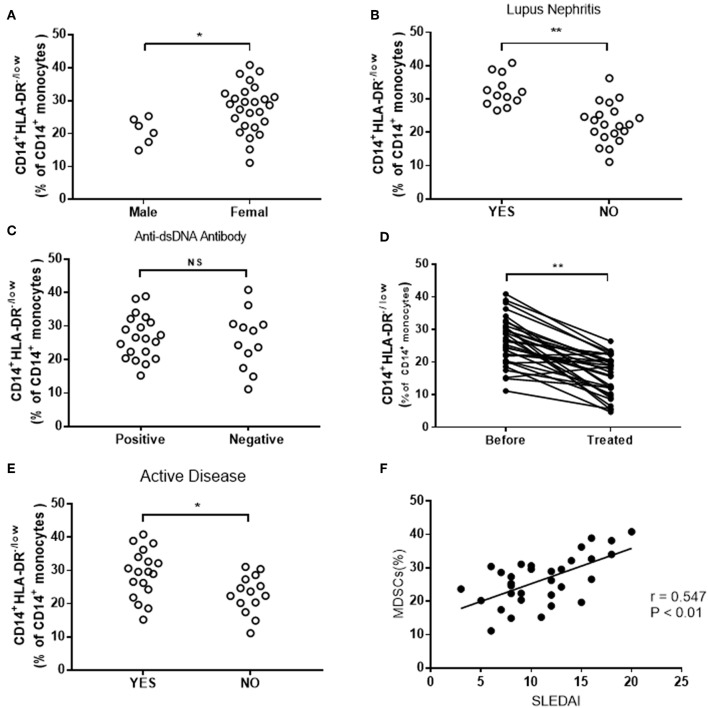
Clinical correlation of M-MDSCs in SLE patients. (A) The frequency of M-MDSCs in female patients was significantly higher than that in male patients. (B) The frequency of M-MDSCs increased in patients with lupus nephritis. (C) No significant difference was detected in M-MDSCs between anti-dsDNA-positive and anti-dsDNA-negative groups (YES, lupus nephritis; NO, non-lupus nephritis). (D) The frequency of M-MDSCs was significantly decreased after treatment. (E) The level of M-MDSCs in patients with active SLE was higher than that in patients with inactive SLE (YES, active SLE patients; NO, inactive SLE patients). (F) M-MDSCs was positively correlated with the score of SLEDAI in SLE patients. Each point represents an individual. The horizontal bar represents the average. *P < 0.05; **P < 0.01.